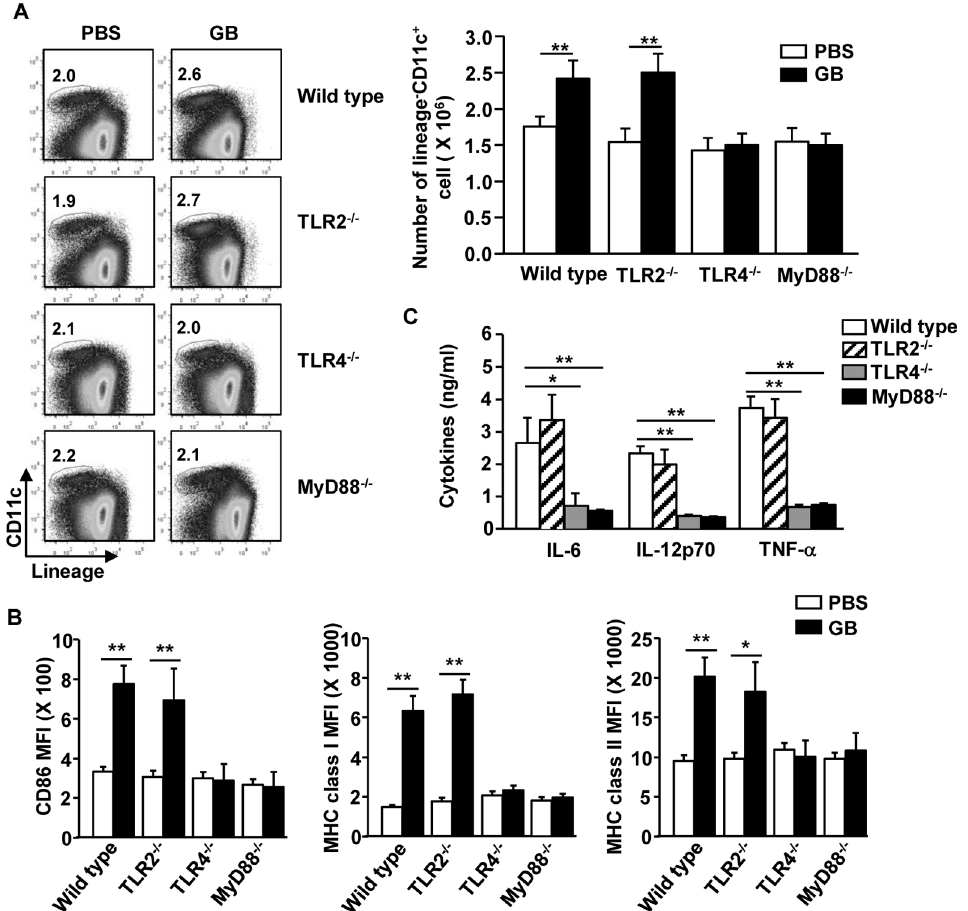
Fig 4. TLR4 and MyD88 singling pathway is essential for GB-induced DC activation. C57BL/6, TLR2 -/- , TLR4 -/- or MyD88 -/- mice were injected i . p . with PBS or 50 mg/kg GB for 24 hours. (A) Percentage of lineage - CD11c + spleen DCs was analyzed on a flow cytometry (left panels). Absolute cell number of spleen DCs within live cells were shown (right panel). (B) Expression level of CD86, MHC class I and MHC class II were measured by flow cytometry. (C) IL-6, IL-12p70 and TNF- α levels in sera were shown. All data are representative or the average of analyses of 6 samples from 3 independent experiments. * p < 0 . 05 , ** p < 0 . 01